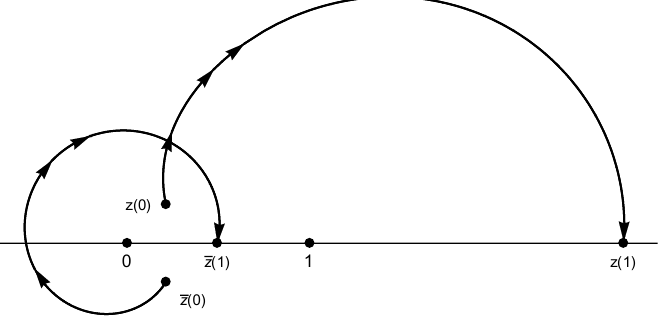
Figure 5.4: z , ¯ z -curves of the configuration